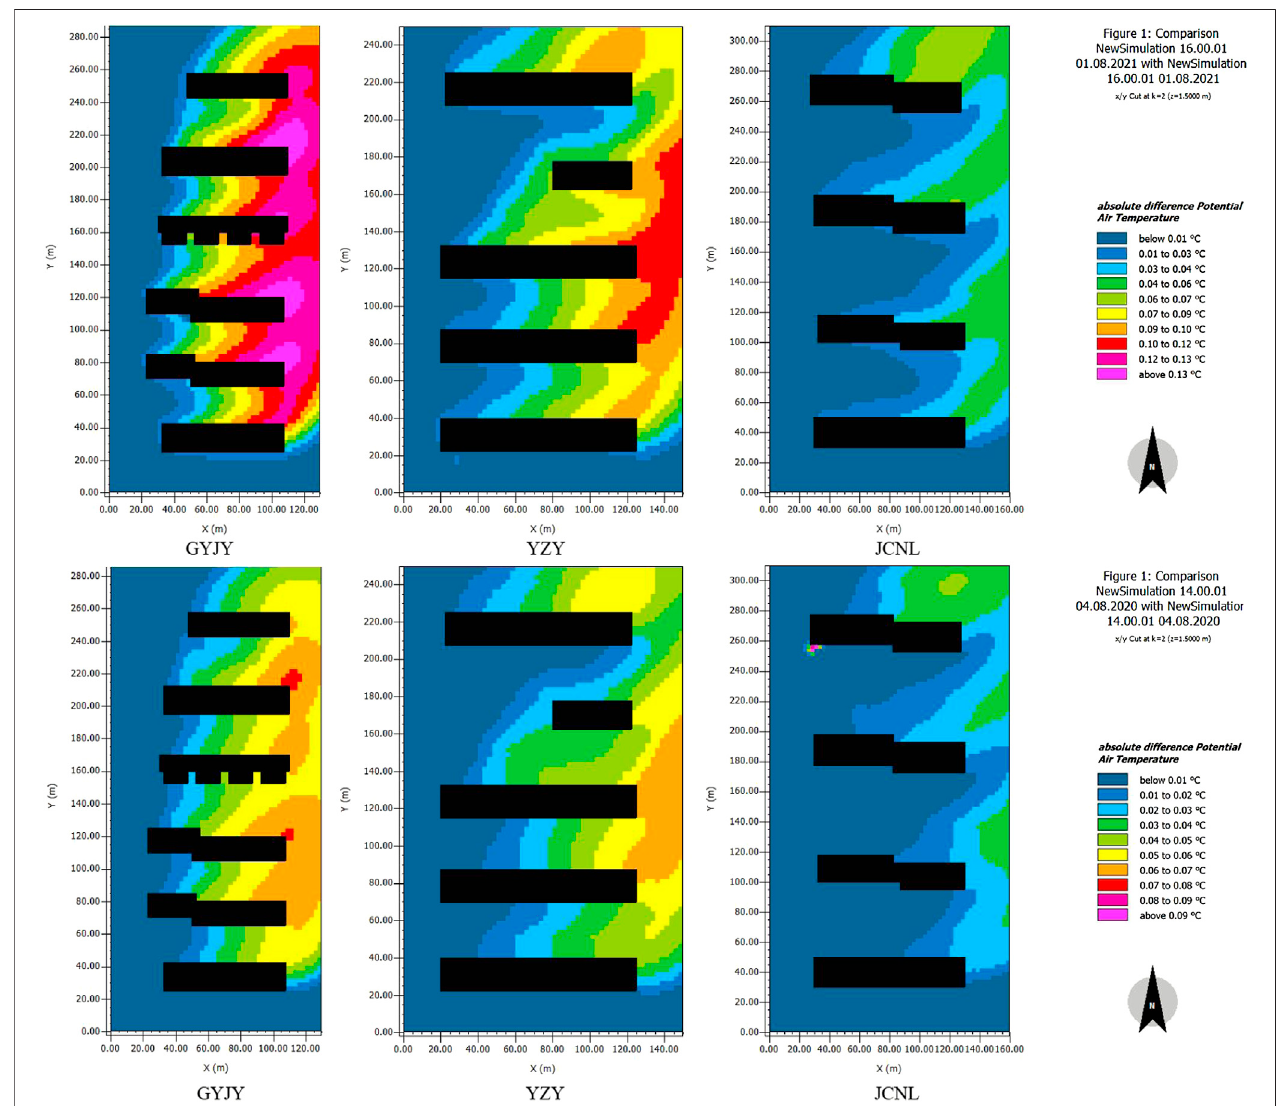
FIGURE 2 | The spatial distribution of pedestrian-level cooling intensity of green roofs at the time when the maximum air temperature of the day is reached. They were 4:00 p.m. on 1 August 2021 (Top) and 2:00 p.m. on 4 August 2020 (Bottom).